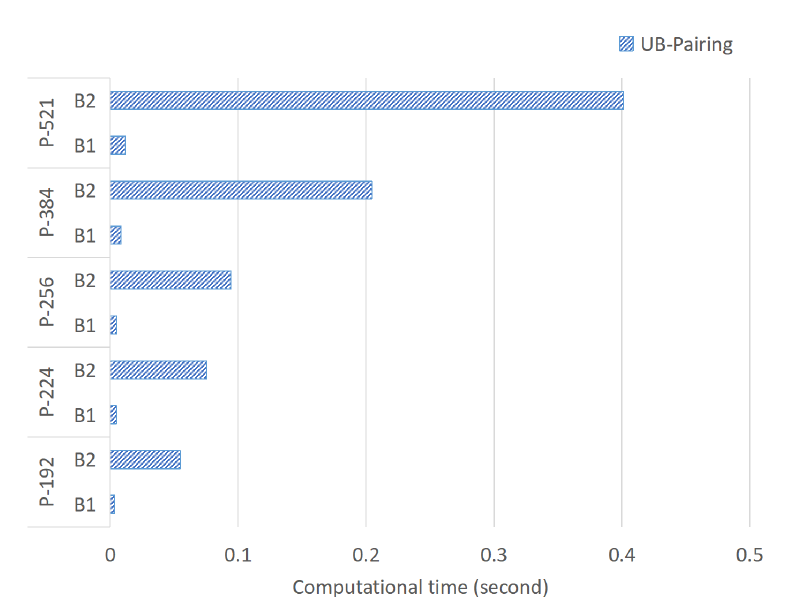
Figure 5. Average computing time on two virtual machines in experiment II.